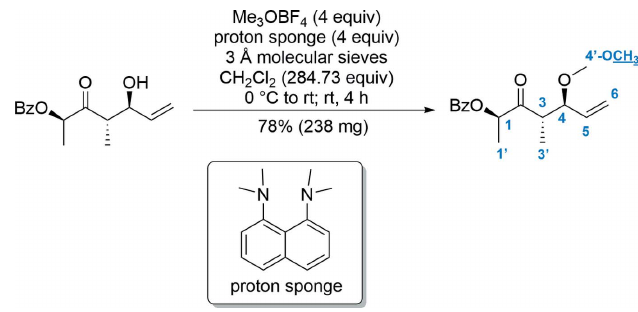
Figure 3 Reaction conditions for the methylation of the allylic alcohol.